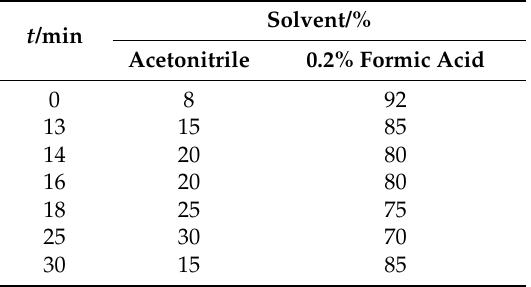
Table 4. HPLC method conditions for the